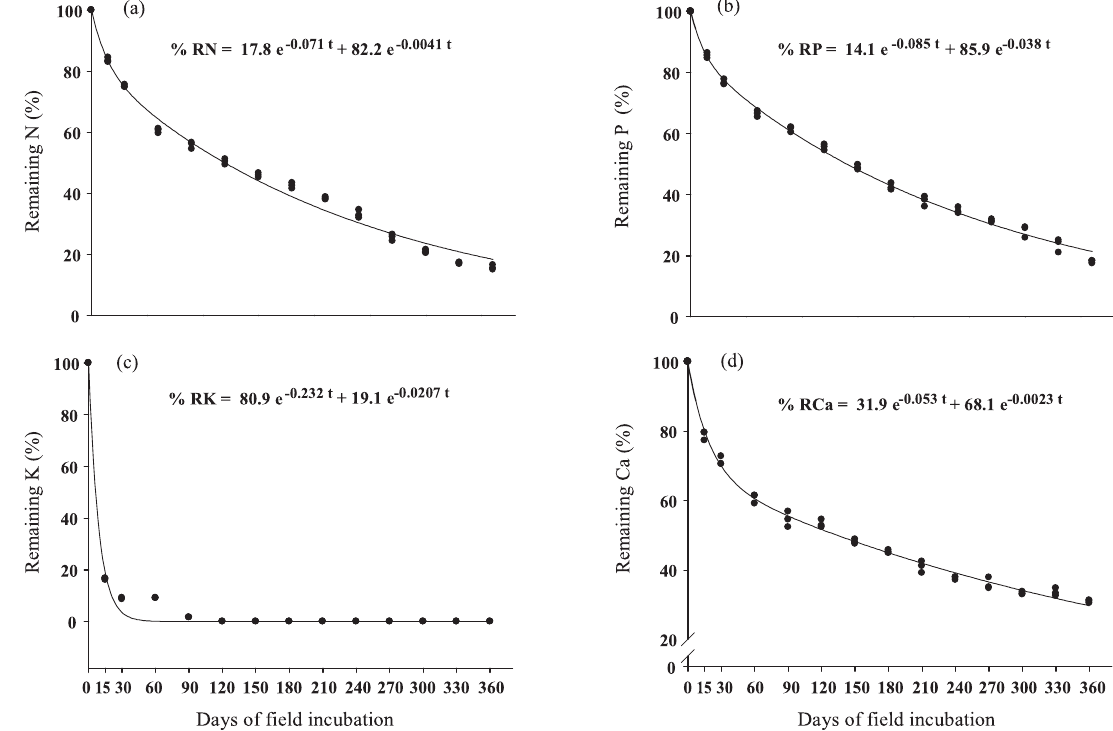
Figure 3. remaining (%) nitrogen (a), phosphorous (b), potassium (d) and calcium (d) in poultry litter after periods up to one year of field incubation in litter